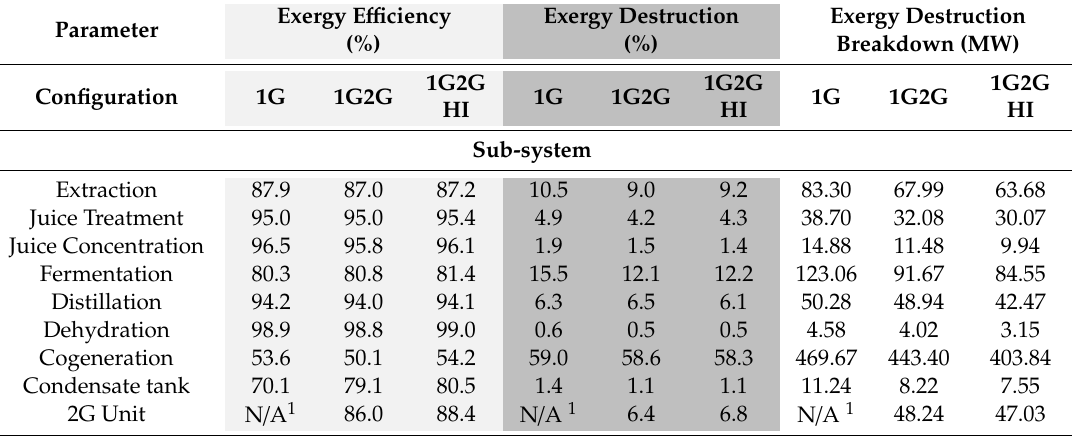
Table 2. Exergy e ffi ciency and irreversibilities of the